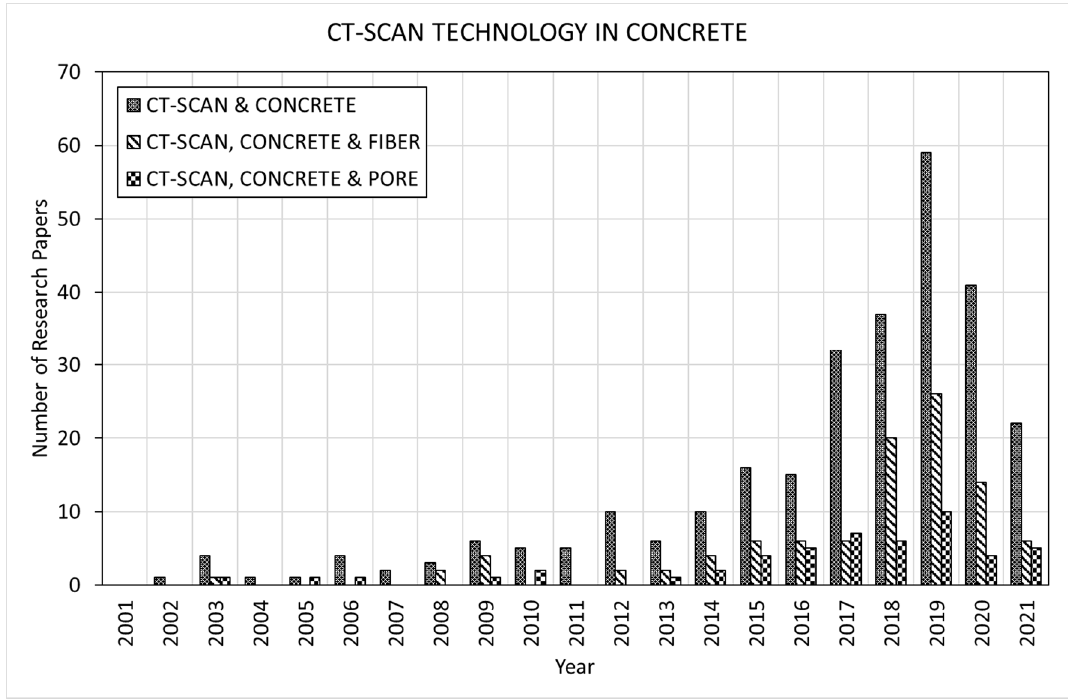
Figure 1. Evolution in the number of scientific publications related to computed tomography in concrete (2001–2021).